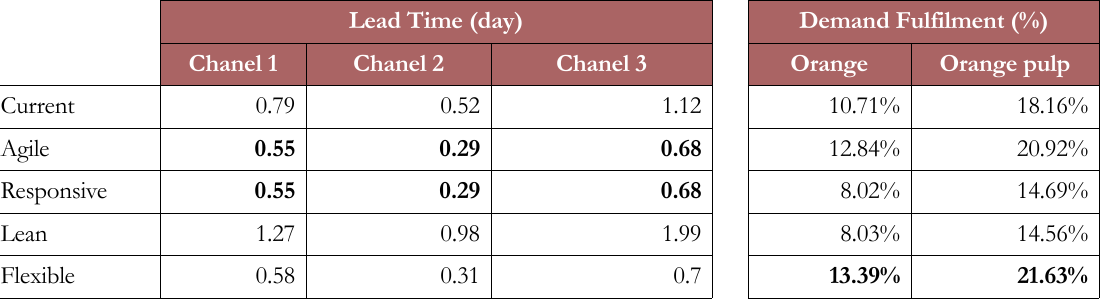
Table 4b. Leadtime and Demand fulfilment for Orange